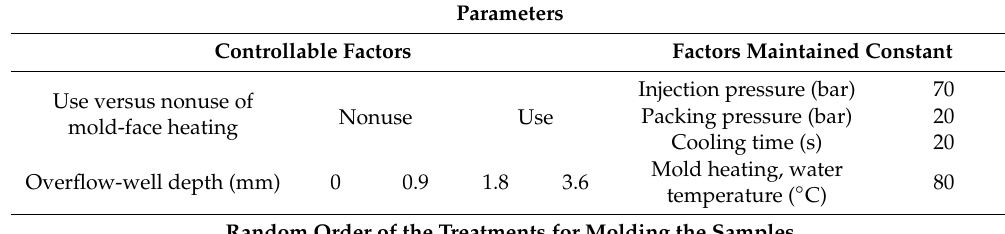
Figure 3. Schematics of surface measurement and pressure sensor position: ( a ) schematic of surface roughness measurement; ( b ) schematic of weldline depth measurement; ( c ) schematic and position of mold-cavity pressure sensor; and ( d ) schematic and position of grinding stage. Table 1. Configuration of the overflow-well and mold-face heating for the molding of long-glass-fiber-reinforced polypropylene (PP/LGF) samples.